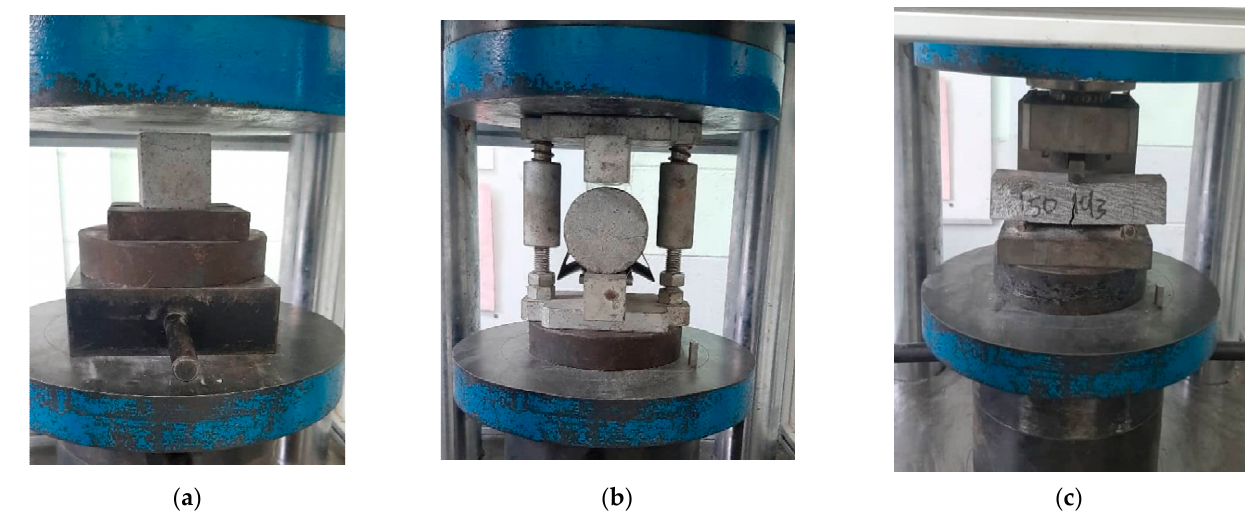
Figure 4. Hardened state tests: ( a ) the compression test, ( b ) the split tensile test, and ( c ) the flexure test.